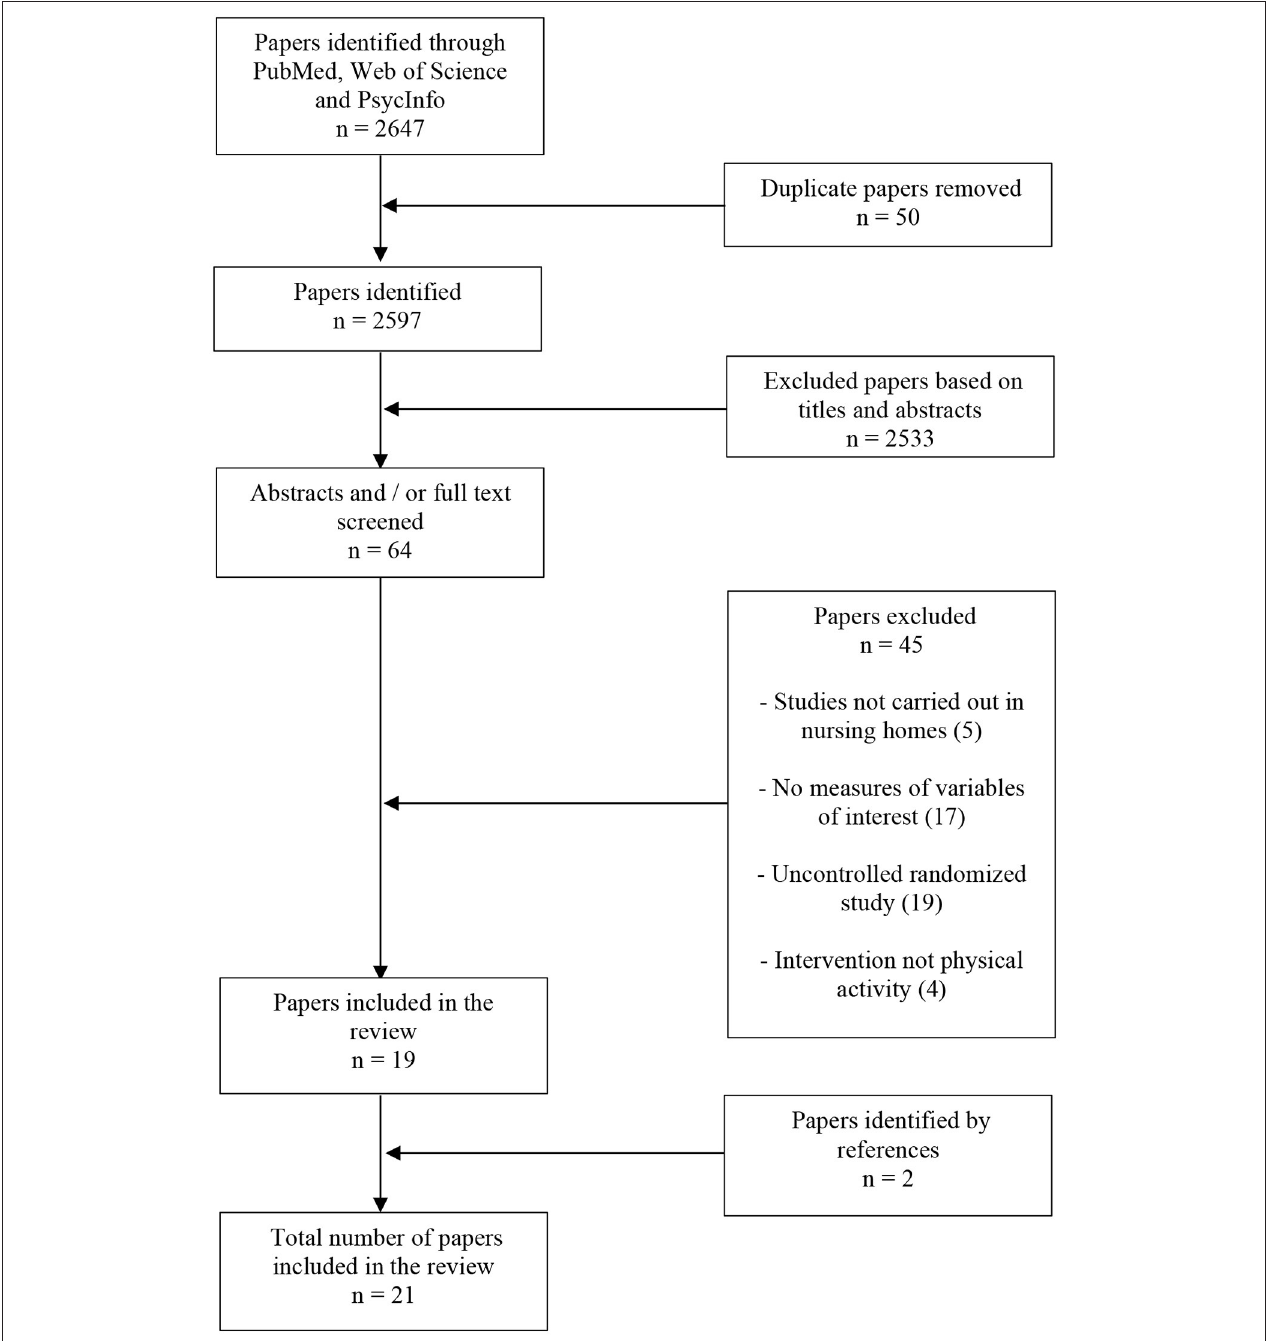
FIGURE 1 | Chart flow of the selection